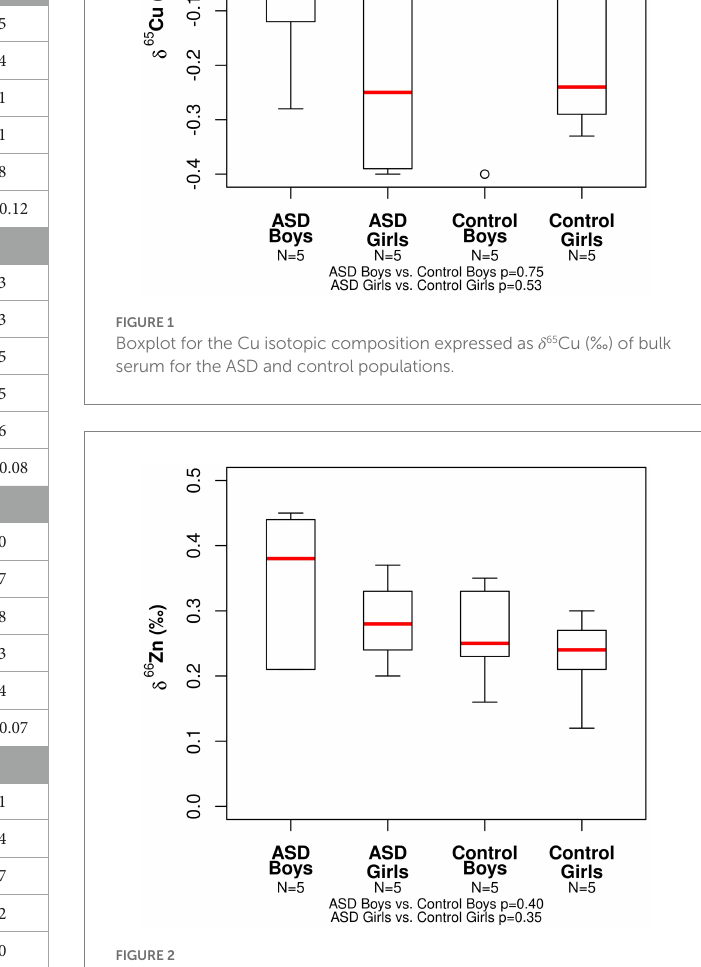
Study population